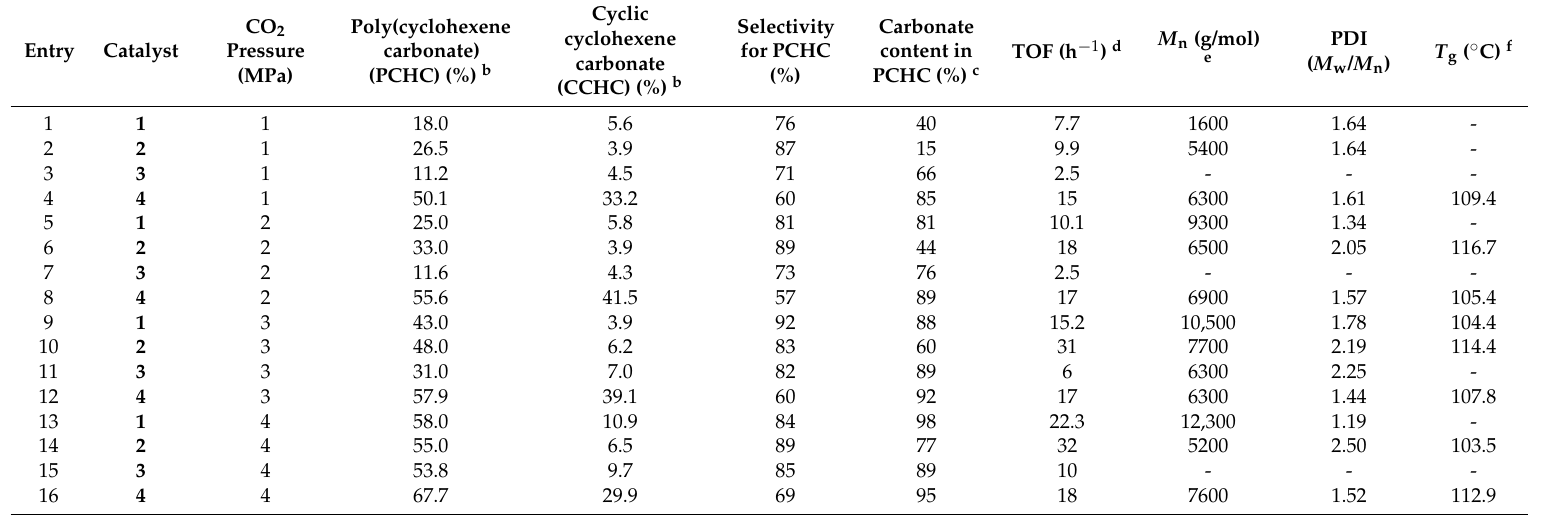
Table 2. Effect of CO 2 pressure on CHO and CO 2 copolymerization a